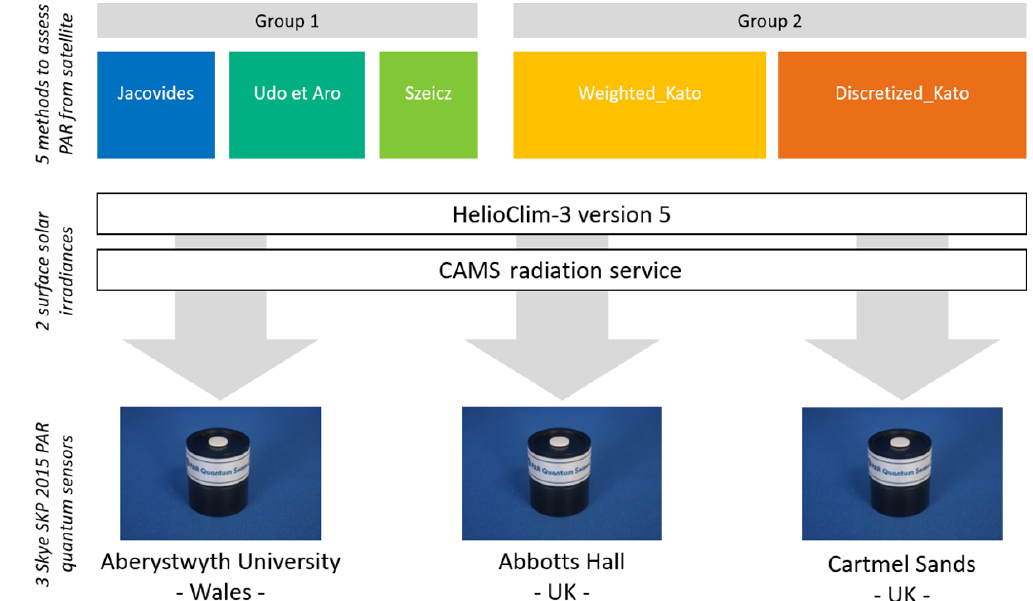
Figure 2. Recapitulative scheme of the quality assessment of five methods to derive PAR from satellite imagery (a) against the measurements collected at three different sites in UK and Wales (c) . Methods are separated into two groups: group 1 methods compute the PAR by multiplying the satellite-retrieved SSI by a constant coefficient, while group 2 methods combine a spectral distribution of the solar radiation in cloud-free conditions with a cloud extinction derived from the SSI. All these methods have been tested using two different SSIs: HC3v5 and CAMS-Rad (b) . Table 2. Aberystwyth University. Number of coincident data, mean of measurements, bias and root mean square error (RMSE) and correla- tion coefficient for the five PAR-satellite methods and for both HC3v5 and CAMS-Rad data sets. Group 1 Group 2 Jacovides Udo and Aro Szeicz Weighted_Kato Discretized_Kato Number of pairs